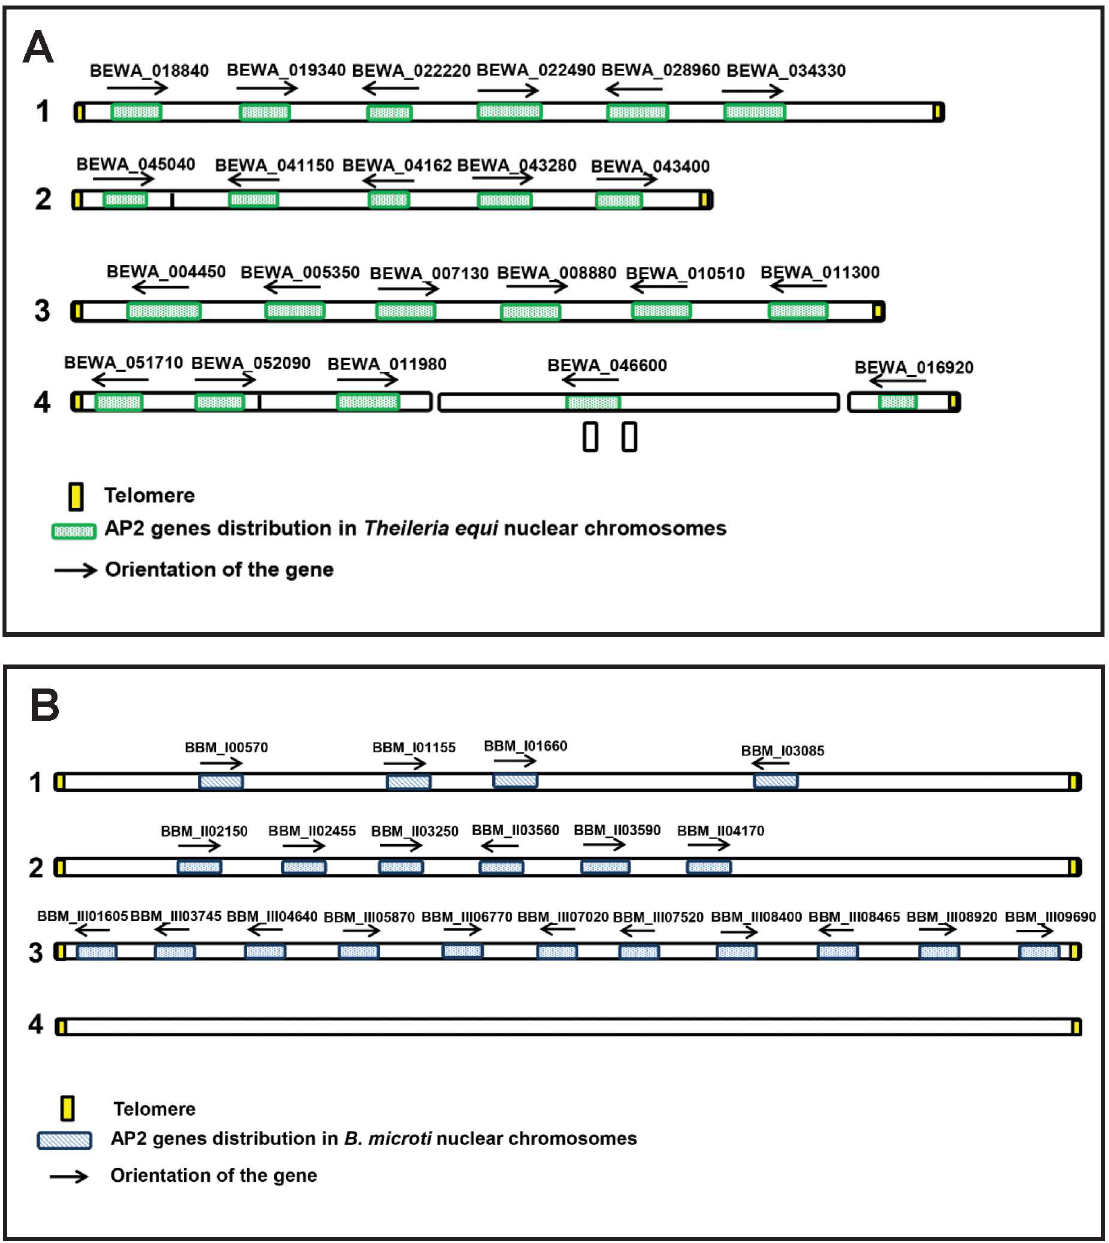
Fig 3. (A) Schematic representation of the location of the 22 AP2 genes identifiedin the genomeof T . equi (data not presented in scale). (B) Schematic representation of the location of the 21 AP2 genes identifiedin the genome of B . microti (data not presented in